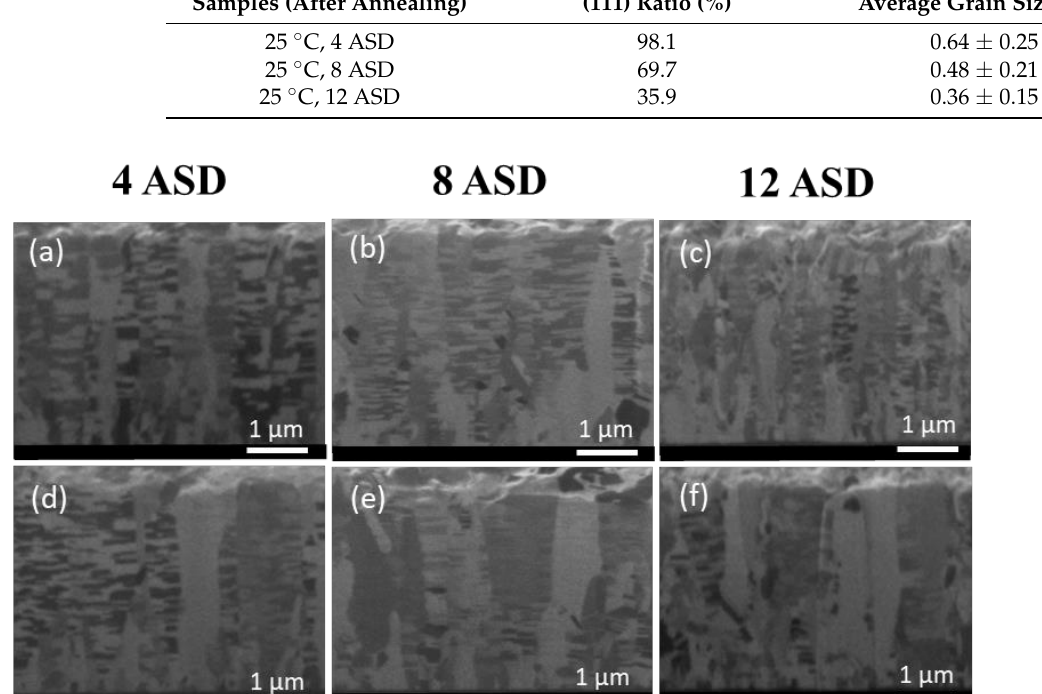
Figure 3. Cross-sectional FIB images of the as-fabricated ( a – c ) and annealed ( d – f ) nt-Cu films deposited with various current densities of 4, 8, and 12 ASD, respectively. The nt-Cu films were electrodeposited at 25 °C and the annealing was conducted at 200 °C for 10 h. Table 1. Degree of (111) orientation and grain size of the films deposited at 25 °C.